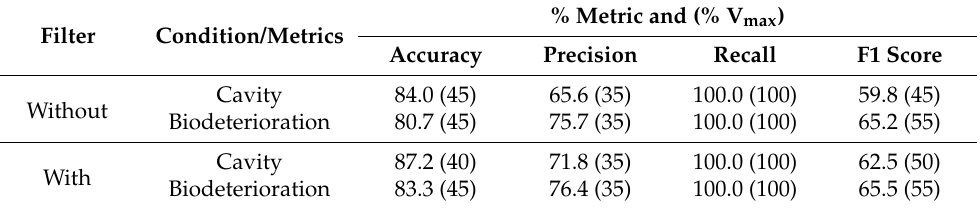
Table 5. Maximum percentages of the metrics of the confusion matrix and respective percent- ages of the maximum velocity (% V max ) obtained for zones of interest (cavity—Ca or cavity plus biodeterioration—Ca+Bio), using or not using filters in the images. Interpolation algorithm: Ellipses with compensation.